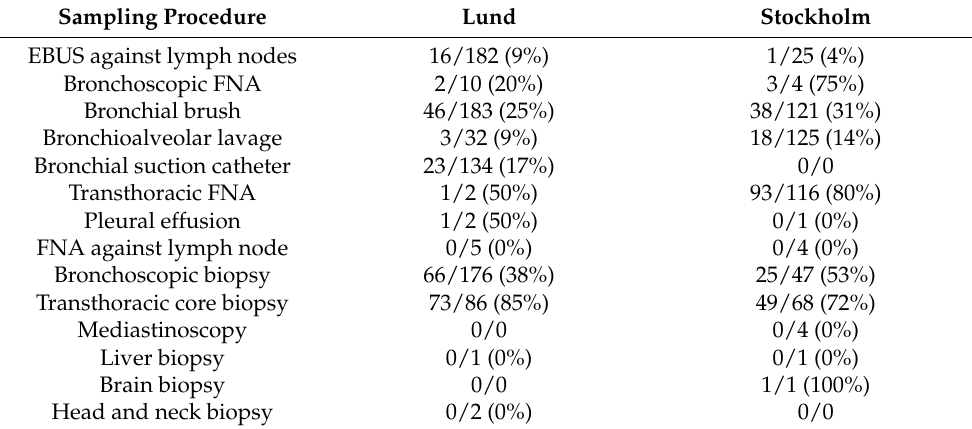
Table 5. Pre-surgical sampling with malignant diagnosis/attempted procedures for consecutive surgically treated primary lung